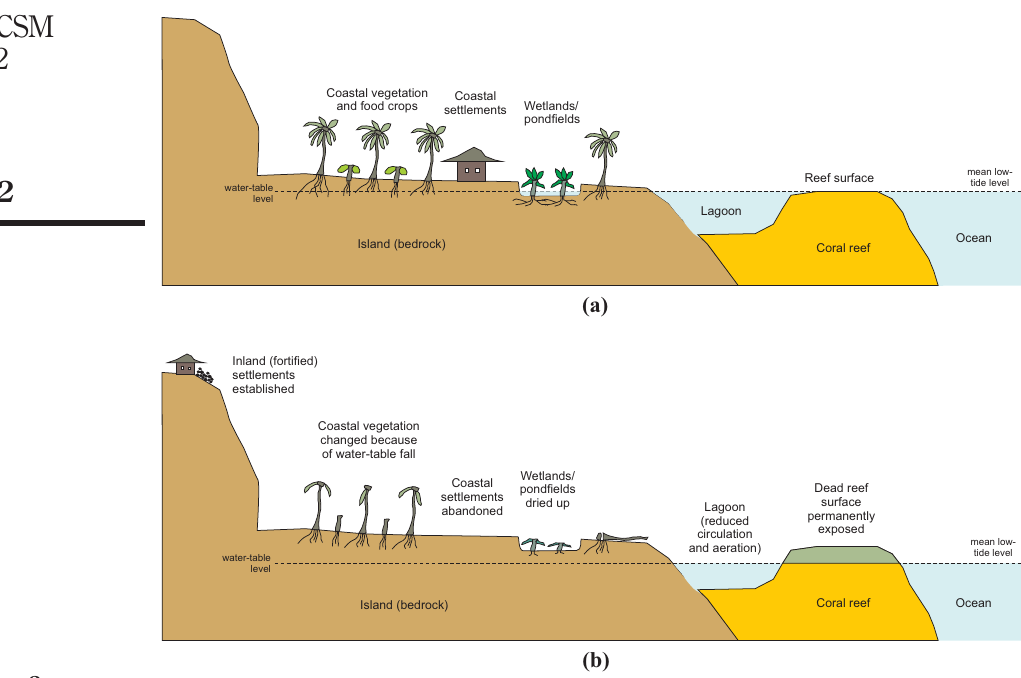
Figure 2. Changes in